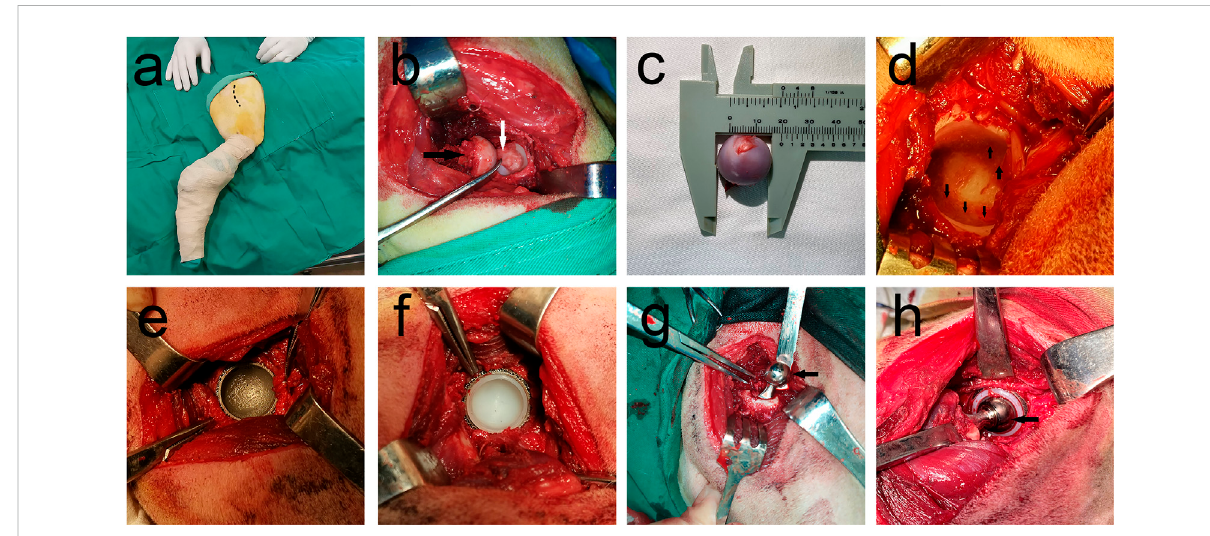
FIGURE 2 THA surgery procedure. (A) Preparation of surgical area, Dotted line shows the planned incision for surgery; (B) Femoral head removal using swing saw, Black arrow points to the resected femoral head and white arrow points to the unresected ligament of the head of femur; (C) Femoral headdiametermeasurementshowsthatfemoralheaddiameterisapproximately20 mm; (D) Blackarrowshowsthearticularsurfaceafterremovalof articular cartilage, with good bleeding; (E) Installation of the acetabular cup, 3D-printed porous titanium mortar cup in a good position; (F) Complete installation of UHMWPE liner on metal acetabular cup, (G) Installation of the femoral stem and femoral head. Black arrow points to metal femoral head; (H) Joint repositioned and checked for motion. Installed femoral stalk is reinstalled into the acetabular fossa, and the joint movement was checked for obvious loosening and prosthesis dislodgement, favorable prosthesis movement tension, with black arrow denoting the metal femoral